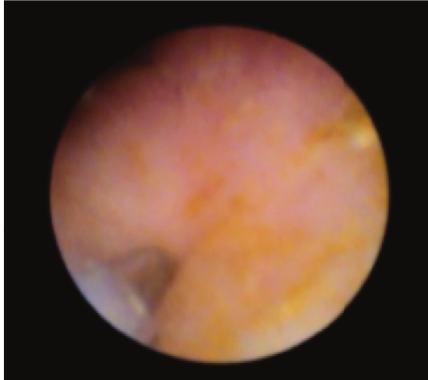
Figure 4: Cholangioscopy-guided steroid